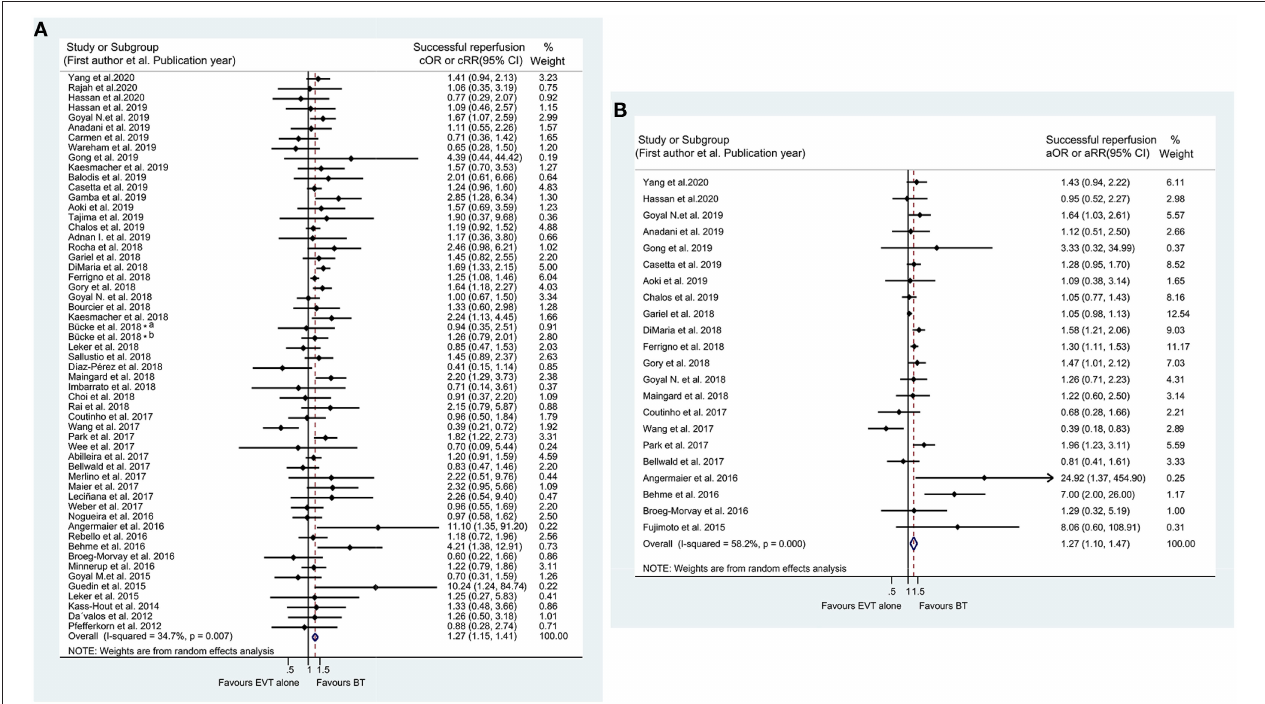
FIGURE 4 | Forest plots of studies assessing successful reperfusion in unadjusted (A) and adjusted (B) analysis. ICA, internal carotid artery. *The acute intracranial vessel occlusion patients with (a) or without (b) concomitant ipsilateral ICA-occlusion or high-grade stenosis were investigated, respectively, in the study by Bücke et al. (